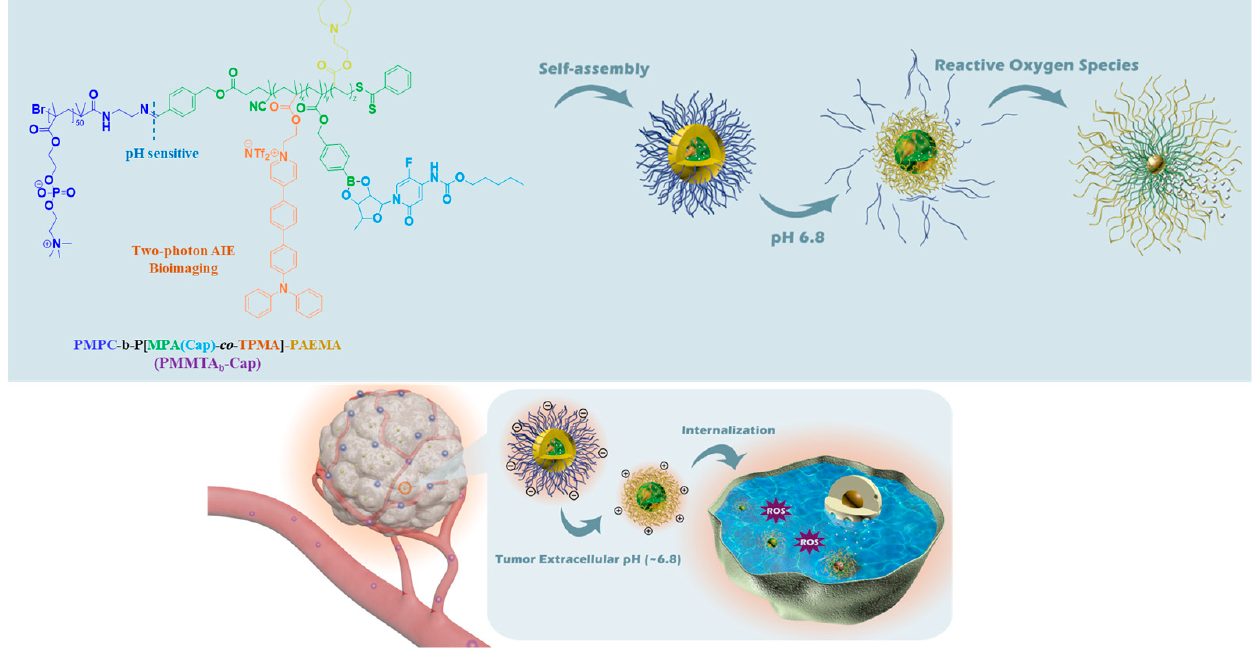
Figure 8. Schematic illustration for preparation of polymeric prodrug PMMTAb-Cap micelles with two-photon bioimaging, pH-triggered size shrinkage and charge-reversal, and ROS-triggered drug release. Adapted with permission from ref. [70]. Copyright 2019 American Chemical Society.